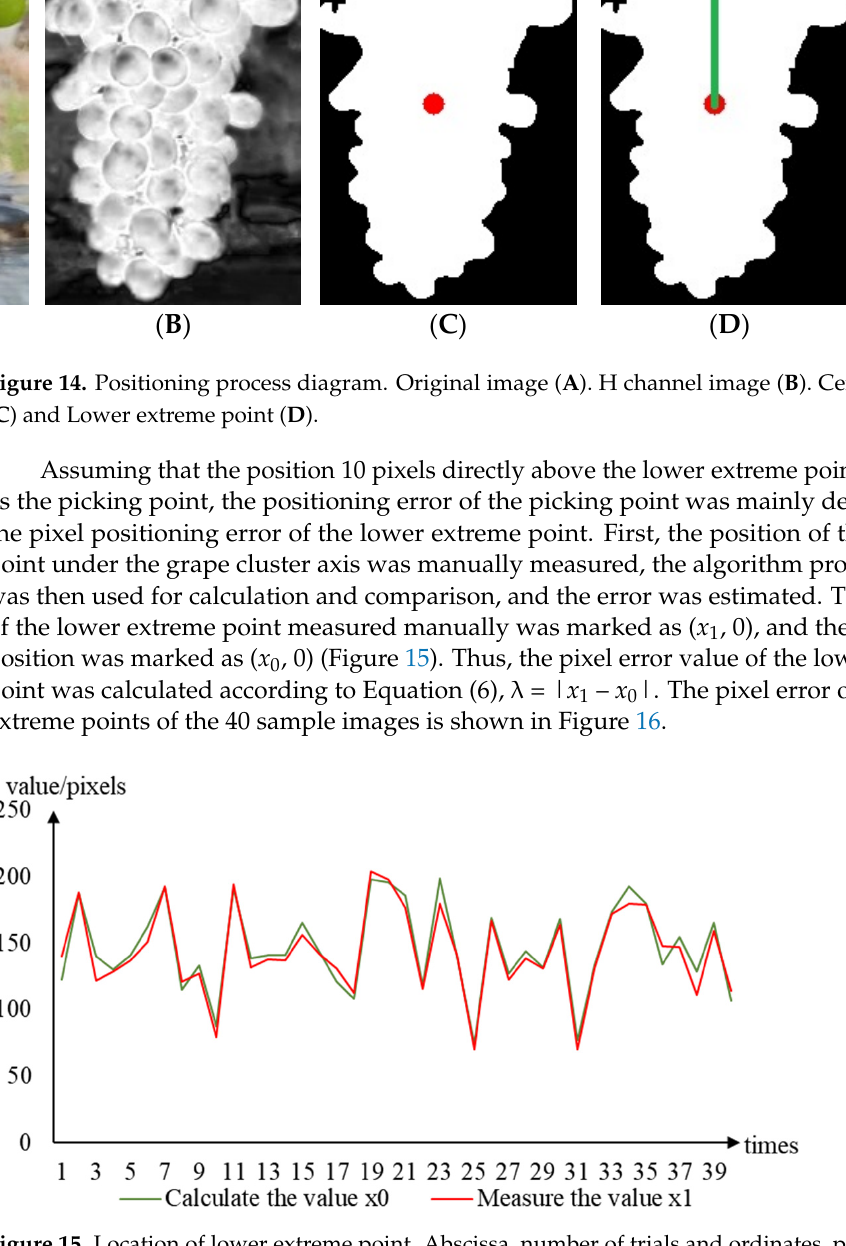
Figure 15. Location of lower extreme point. Abscissa, number of trials and ordinates, pixel value.